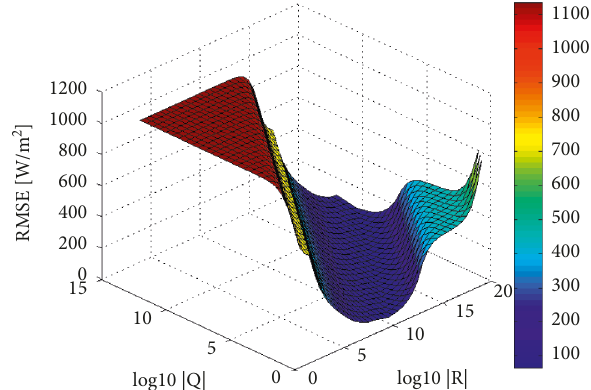
Figure 3: RMSE of the solar GHI intraday forecasting under the different values of covariance matrices R and Q